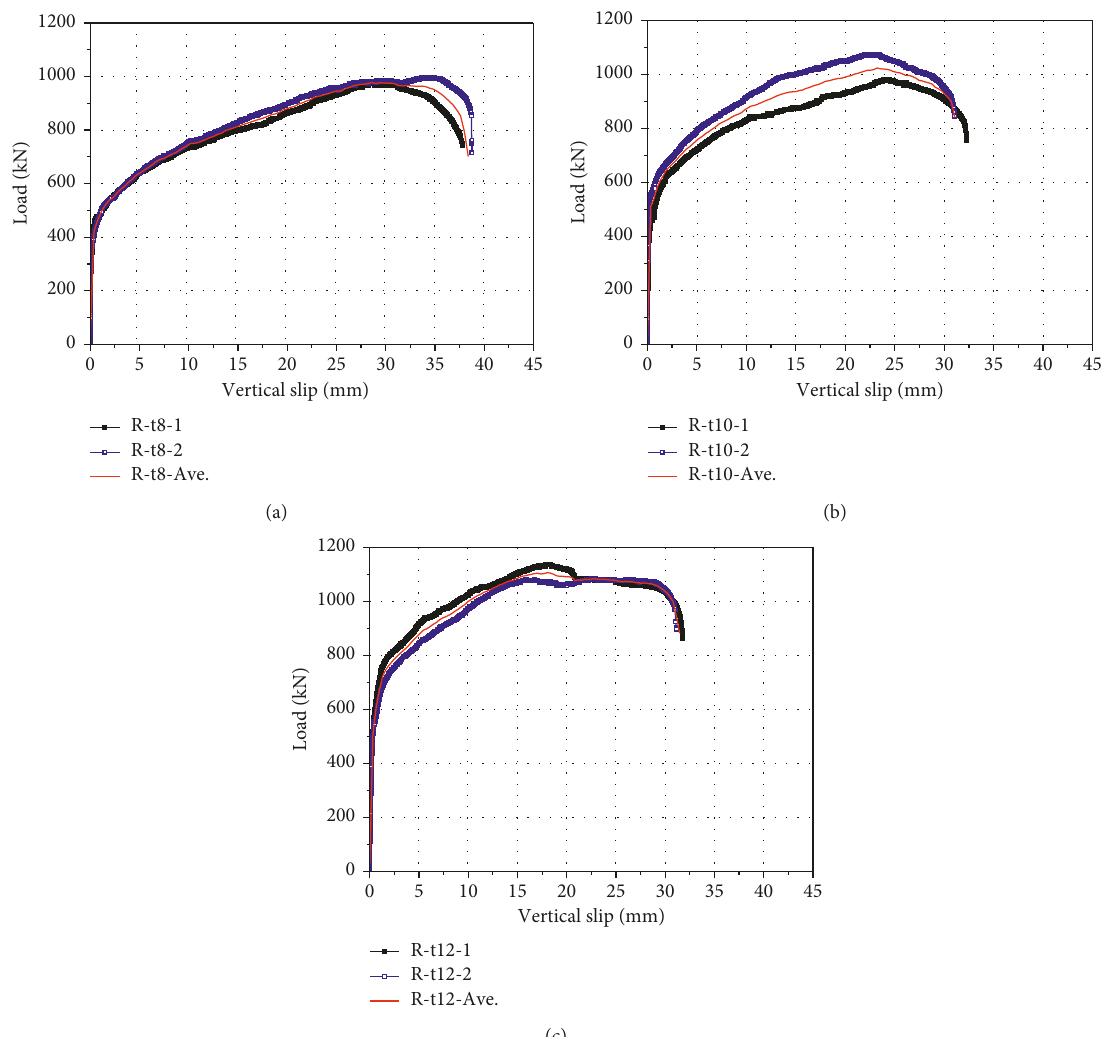
Figure 7: Load-slip curves: (a) group R-t8; (b) group R-t10; (c) group